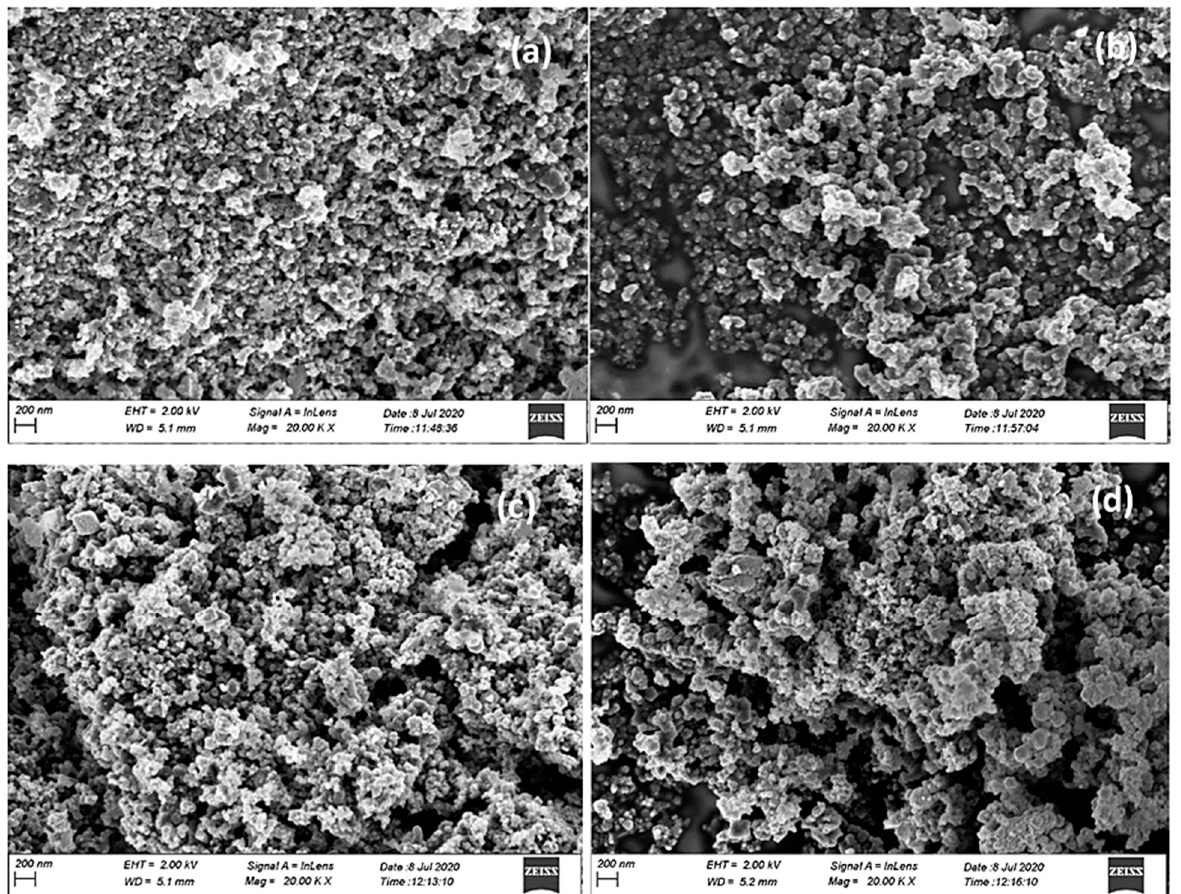
Figure 3. FE-SEM micrographs of tire waste-derived AC ( a , b ) and M-AC ( c , d ).